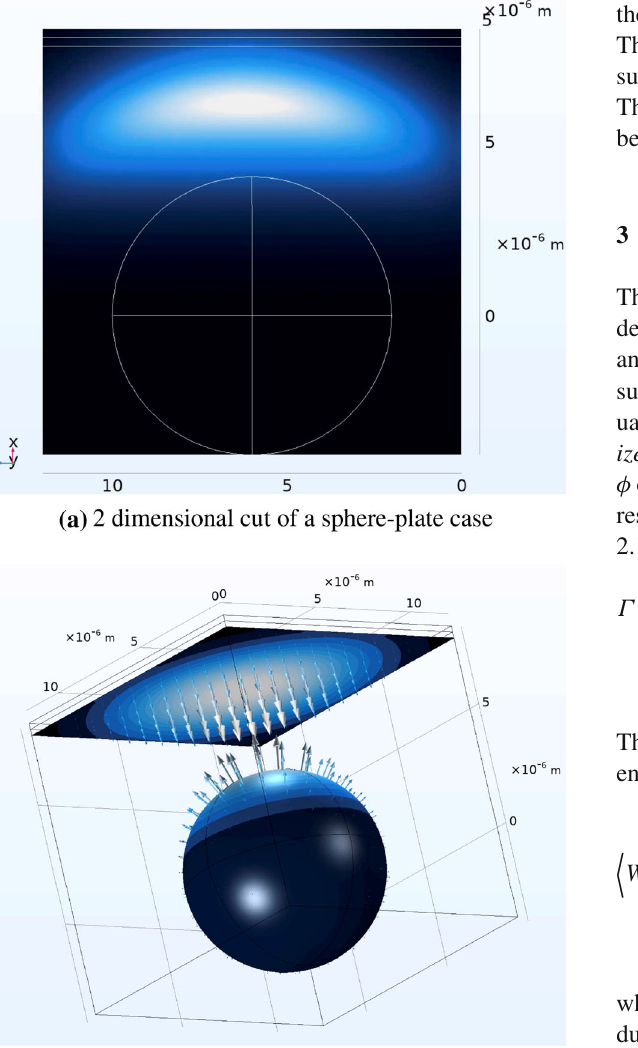
Fig. 3 Panel ( a ) shows a 2 dimensional section cut of a sphere-plate case using the numerical worldline technique. The approach was imple- mented using Open MPI-enabled c-code and the analysis was run on 100 2.40 GHz Intel Skylake CPUs. The model grid was a 50 × 50 × 50 grid with a 2000 unit-loop ensemble. The bottom plot shows a vector plot of forces normal to model surfaces and was created by importing the worldline numerics results into COMSOL